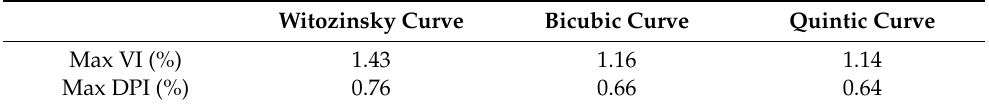
Table 4. Flow uniformity indexes of three contraction curves.